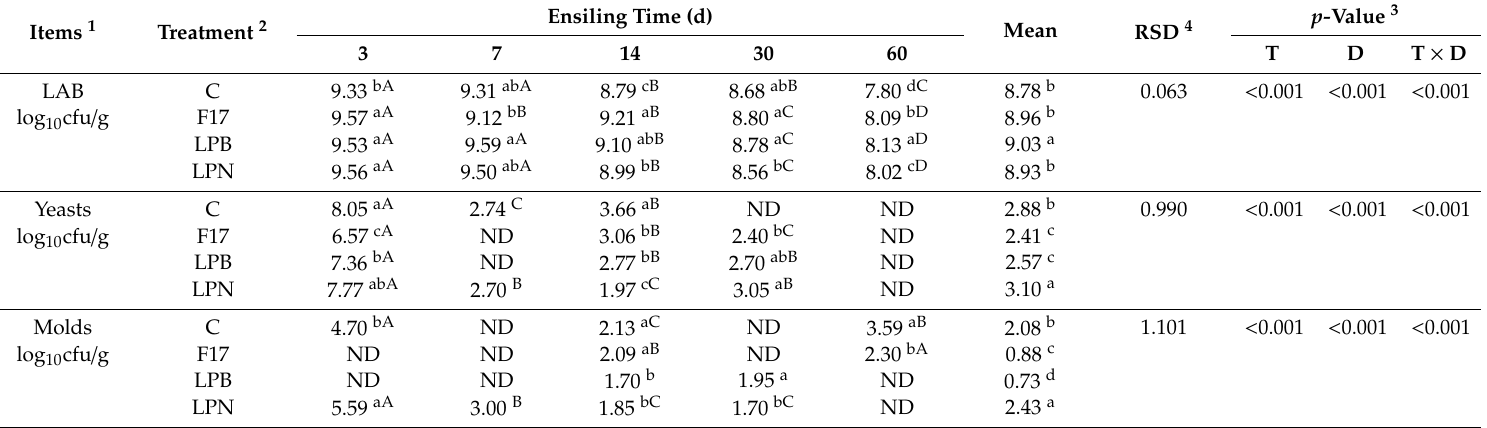
Table 2. E ff ects of additives and ensiling time on the microbiological composition of alfalfa (mean ± RSD).